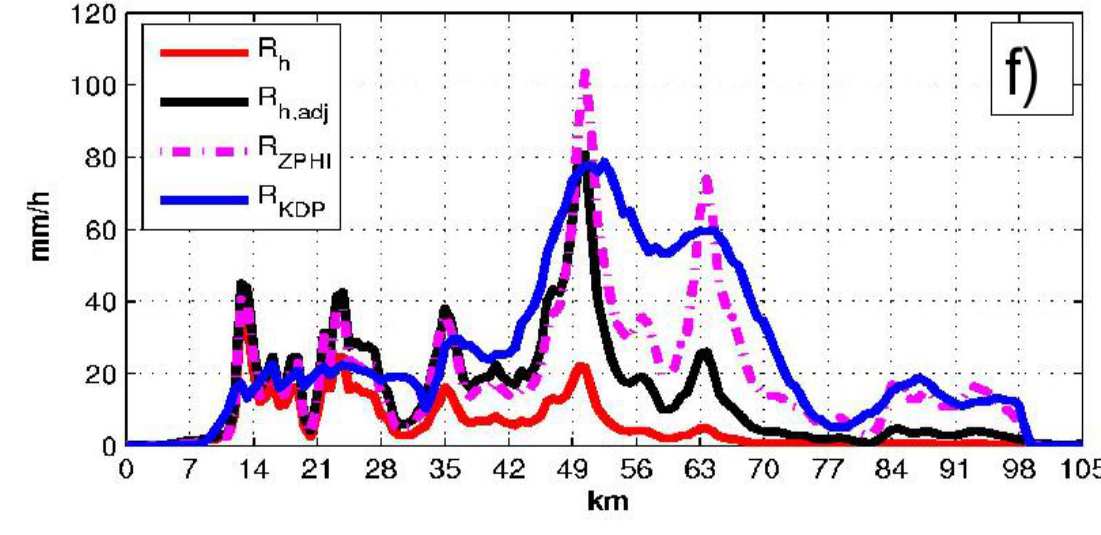
Figure 4. Rainfall accumulation since 00:00 UTC to 09:00 UTC on 16 August 2006 estimated along line A–B with different